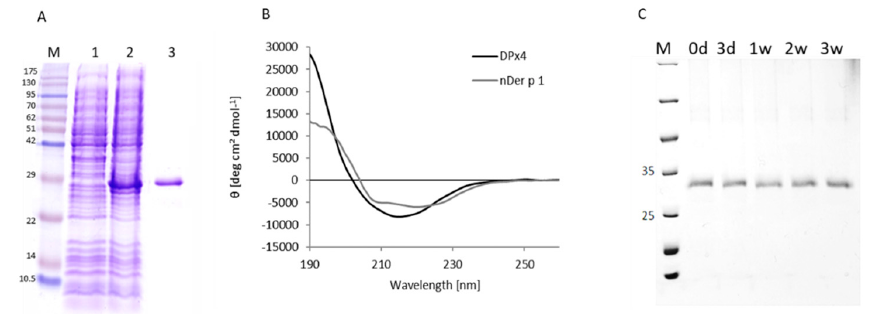
Figure 1. Structural analysis. ( A ). The gel stained with Coomassie brilliant blue shows a single band of 27 kDa corresponding to purified DPx4. M: Molecular weight marker. Lane 1: non-induced culture. Lane 2: culture induced with Isopropyl-1- β -thiogalactopyranoside (IPTG). Lane 3: Purified DPx4 protein. ( B ) Circular dichroism spectra of DPx4 and nDer p 1; spectra were recorded from 190 to 260 nm (x-axis) and circular dichroism (CD) values converted to mean-residue ellipticities (y-axis). ( C ) Stability of DPx4 upon extended storage (0–21 days).